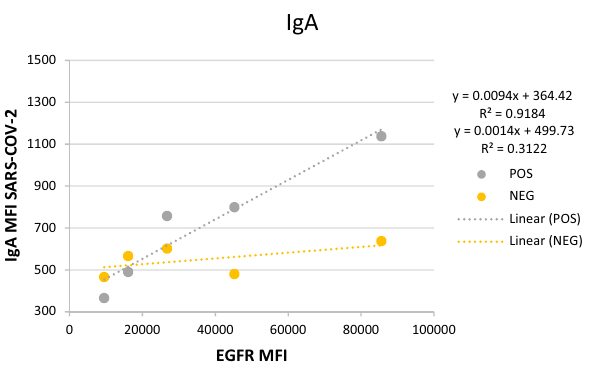
y = 0.0094x + 364.42 R² = 0.9184 y = 0.0014x + 499.73 R² = 0.3122